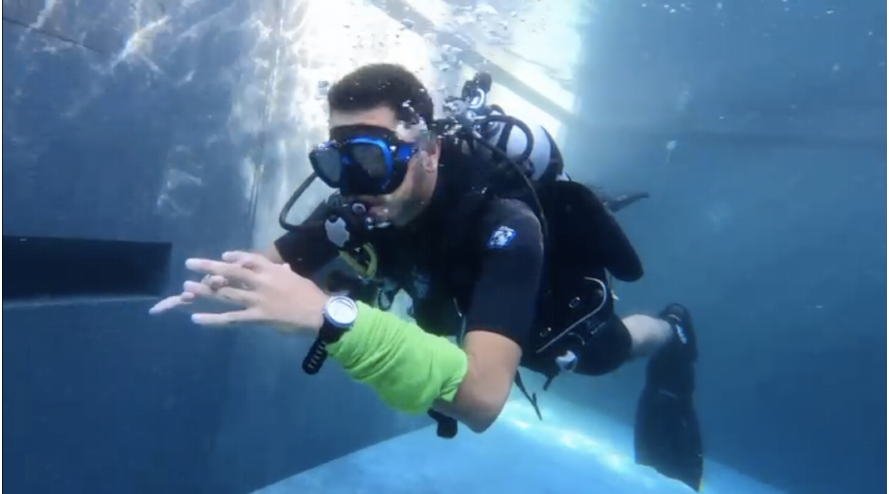
Figure 1. Visual representation of what we envision the system to look like during regular breathing.